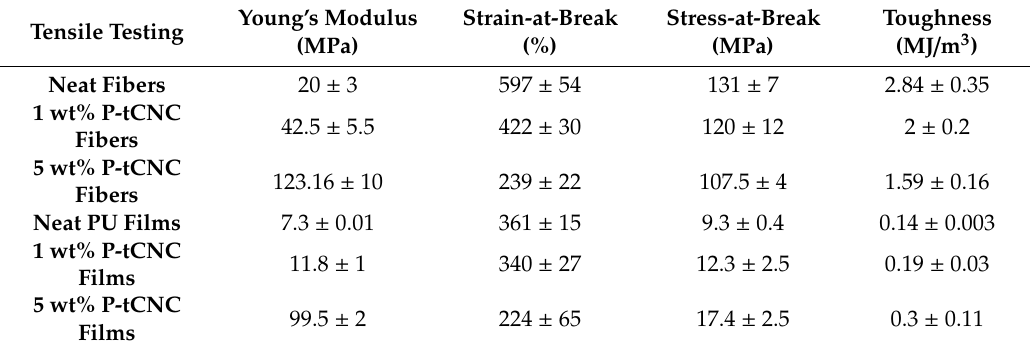
Figure 4. Representative stress-strain curves of ( a ) P-tCNC nanocomposite fibers and ( b ) P-tCNC nanocomposite films. The insets are magnifications near the origin of the graphs, which were used to determine the Young’s modulus of the materials. Table 1. Young’s modulus, stress-at-break, strain-at-break, and toughness of PU and PU/P-tCNC nanocomposite fibers and films determined from a minimum of three samples.